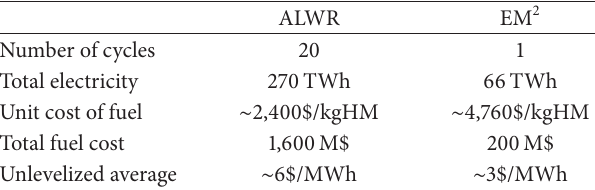
Table 4: Comparison of unlevelized electricity costs. ALWR EM